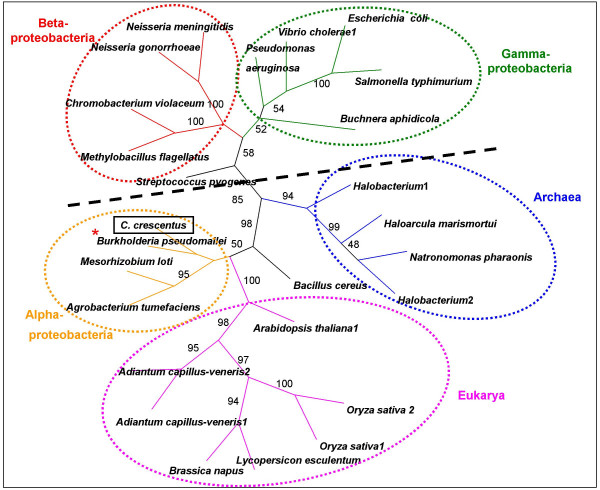
Consensus unrooted tree generated by the Neighbor-Joining distance method for the Phr protein. The symbol * indicates the beta proteobacteria in a different bacterial group. The circles highlight the main groups of Bacteria, Archaea and Eukarya. The homolog of C. crescentus is indicated inside the square box.